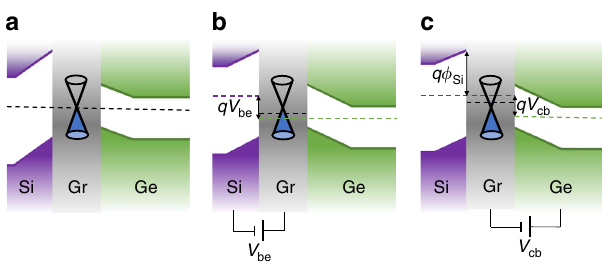
Fig. 4 Energy band diagrams of the Si – Gr-Ge transistor. a Energy bands when no bias is applied. b Energy bands when a forward bias V be > 0 is applied to the emitter junction. c Energy bands when a reverse bias V cb > 0 is applied to the collector